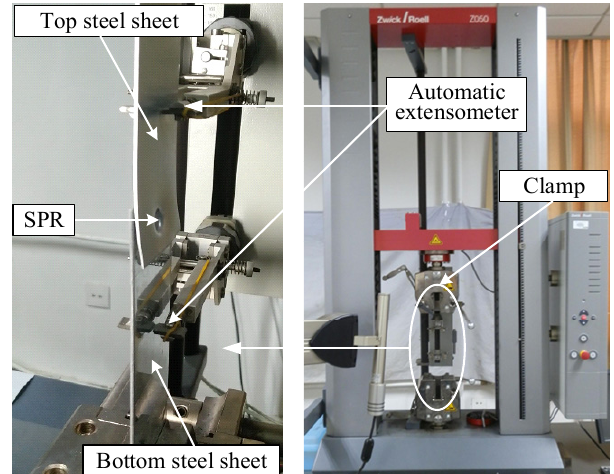
Figure 4. Test set-up for the CFS-SPR connection.